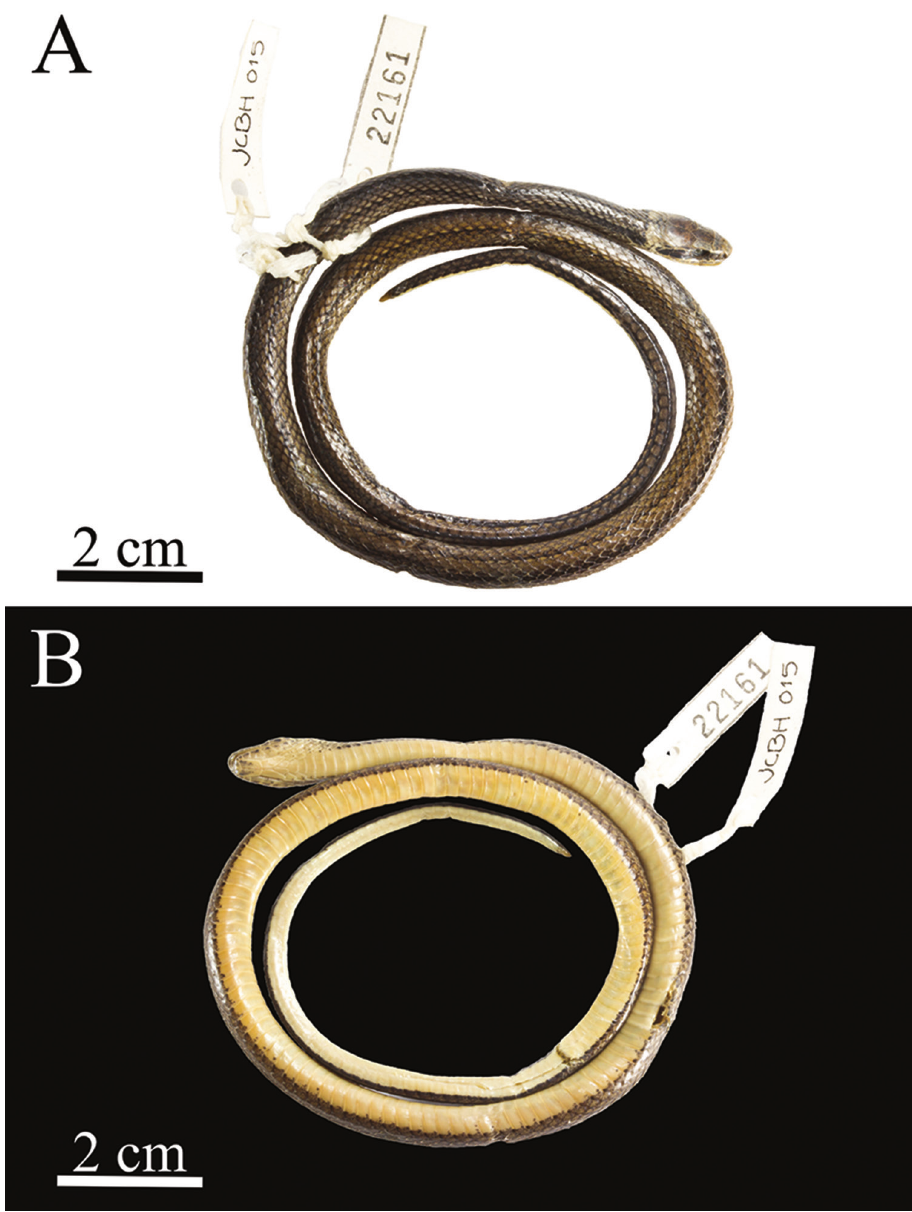
Figure 2. Rhadinaea nuchalis sp. n., holotype (MZFC-HE 22161). Dorsal ( A ) and ventral ( B ) views.